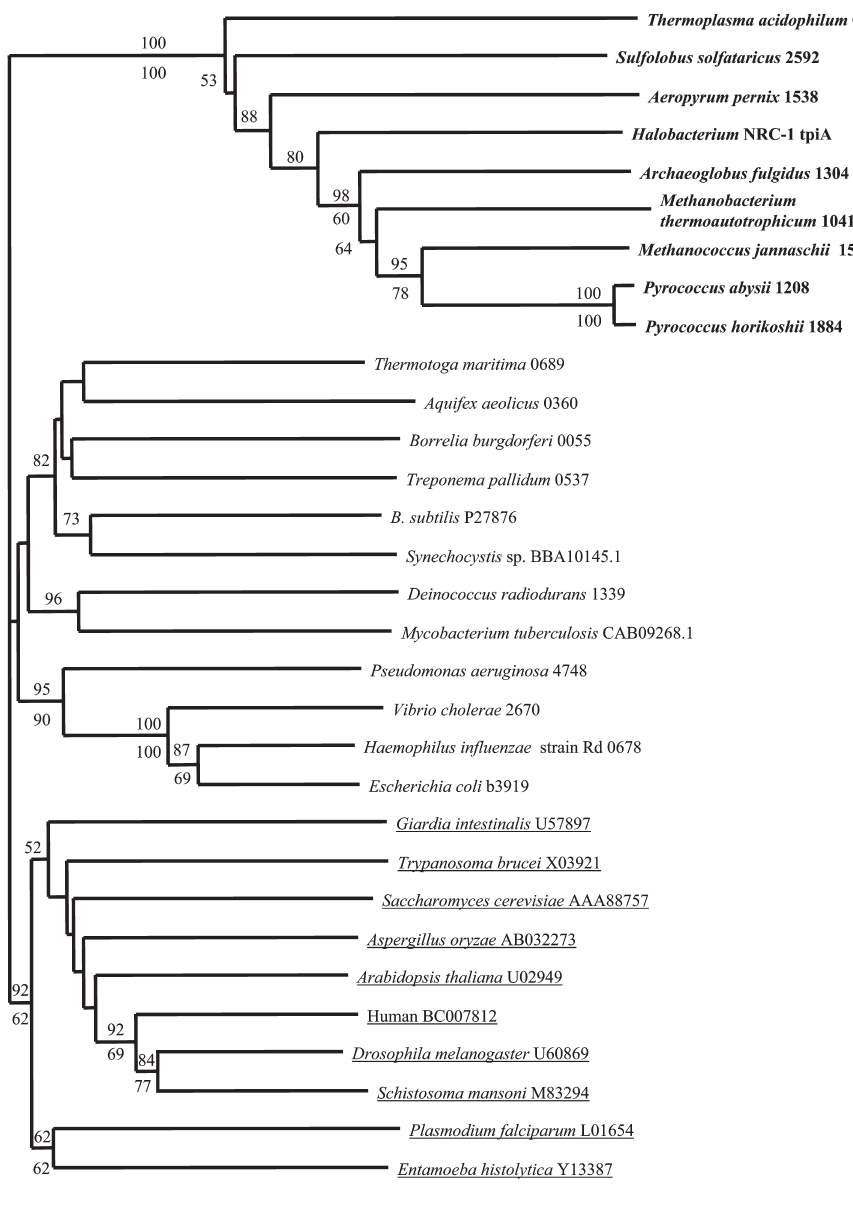
Figure 2. As in the TPI phylogeny, the archaeal sequences (ex - cept that of Haloarcula vallismortis ) cluster together with strong bootstrap support (100% with both phylogenetic meth- ods) on a relatively long branch. The Thermoplasma , S. solf- ataricus , Halobacterium and A. pernix sequences branch near the base of the main archaeal cluster, as observed with the TPI phylogeny. Two large clusters are shown, one with mostly bac-